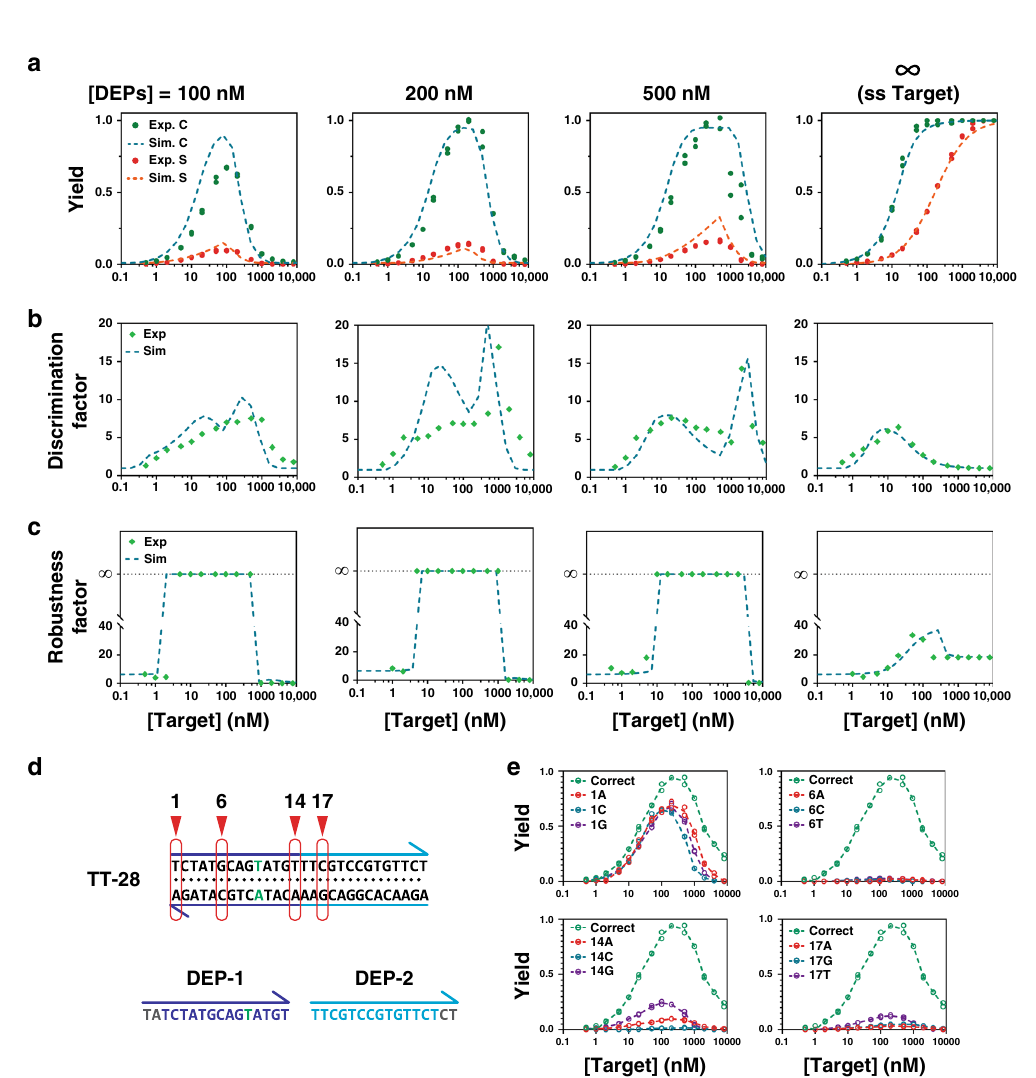
Fig. 5 Experimental validation of DNA Equalizer Gate (DEG). a Experimentally determined yields (Exp) plotted against target concentrations for DEGs with varying DEP concentrations and compared to simulation (Sim). The classic toehold-exchange can be considered as a special case of DEG, where [DEPs] = ∞ . Individual replicates (n = 2) are shown as dots. b Experimentally determined discrimination factors using a pair of synthetic correct and spurious targets ( ΔΔ G 0 = 2.29 kcal/mol) plotted against target concentrations and compared to those predicted in silico. c Robustness factor plotted against target concentrations and compared to in silico prediction. d Schematic illustration of sequences of the target and DEPs. Single-nucleotide mutations were made to the target at positions 1, 6, 14, and 17. e Experimentally determined yields plotted against target concentrations for correct and spurious targets carrying mutations at four designated positions. Individual replicates ( n = 2) are shown as circles. All experiments were run at 37 °C in 1 × PBS buffer with 1 mM Mg 2 + and 20 nM of toehold-exchange beacons. Source data are available in the Source Data fi